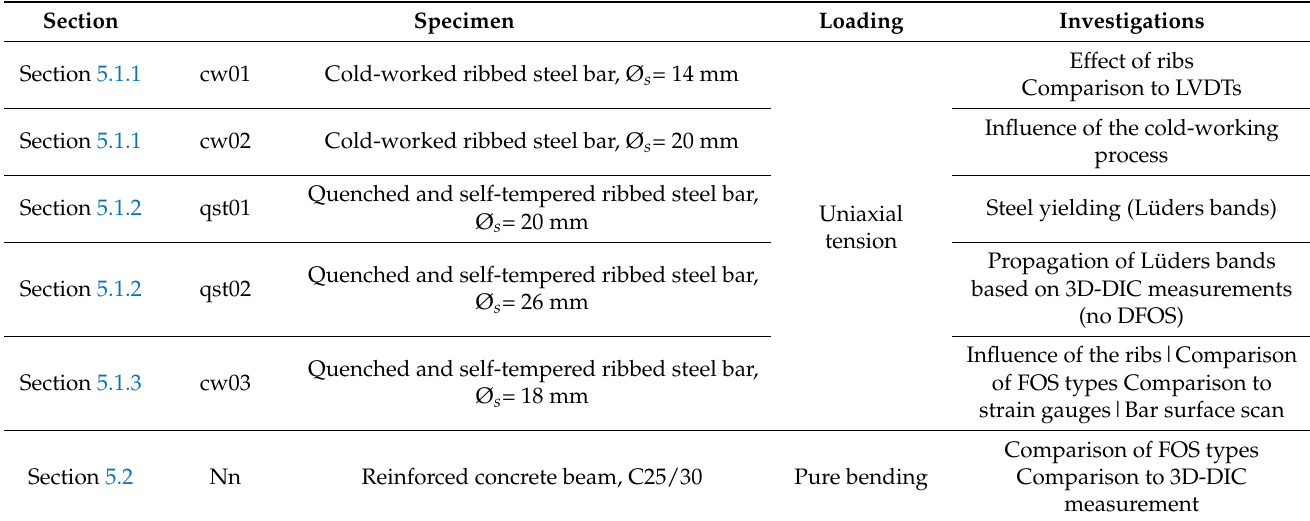
Table 1. Overview of the experiments used for the basic